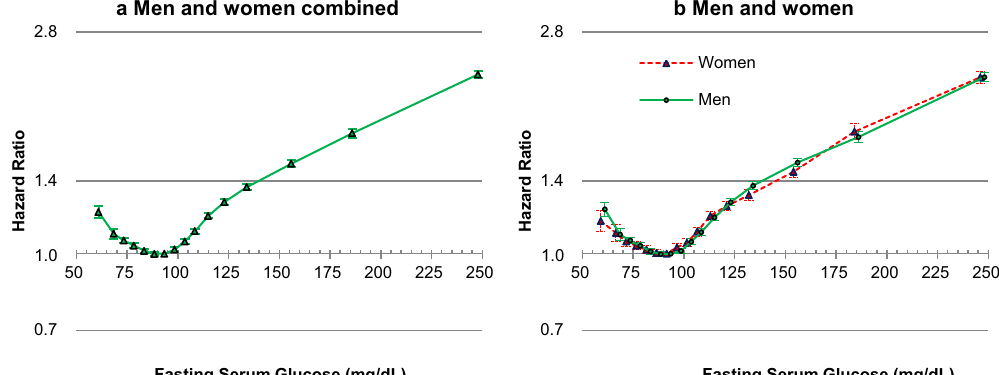
Figure 2. Hazard ratios * associated with 16 categories of baseline fasting serum glucose (FSG) for mortality, according to sex. FSG categories (mg/dL: < 65, 65–69, 70–74, 75–79, 80–84, 85–90, 90–94 [Reference], 95–99, 100–104, 105–109, 110–117, 118–125, 125–139, 140–169, 170–199, ≥ 200). The midpoint was used